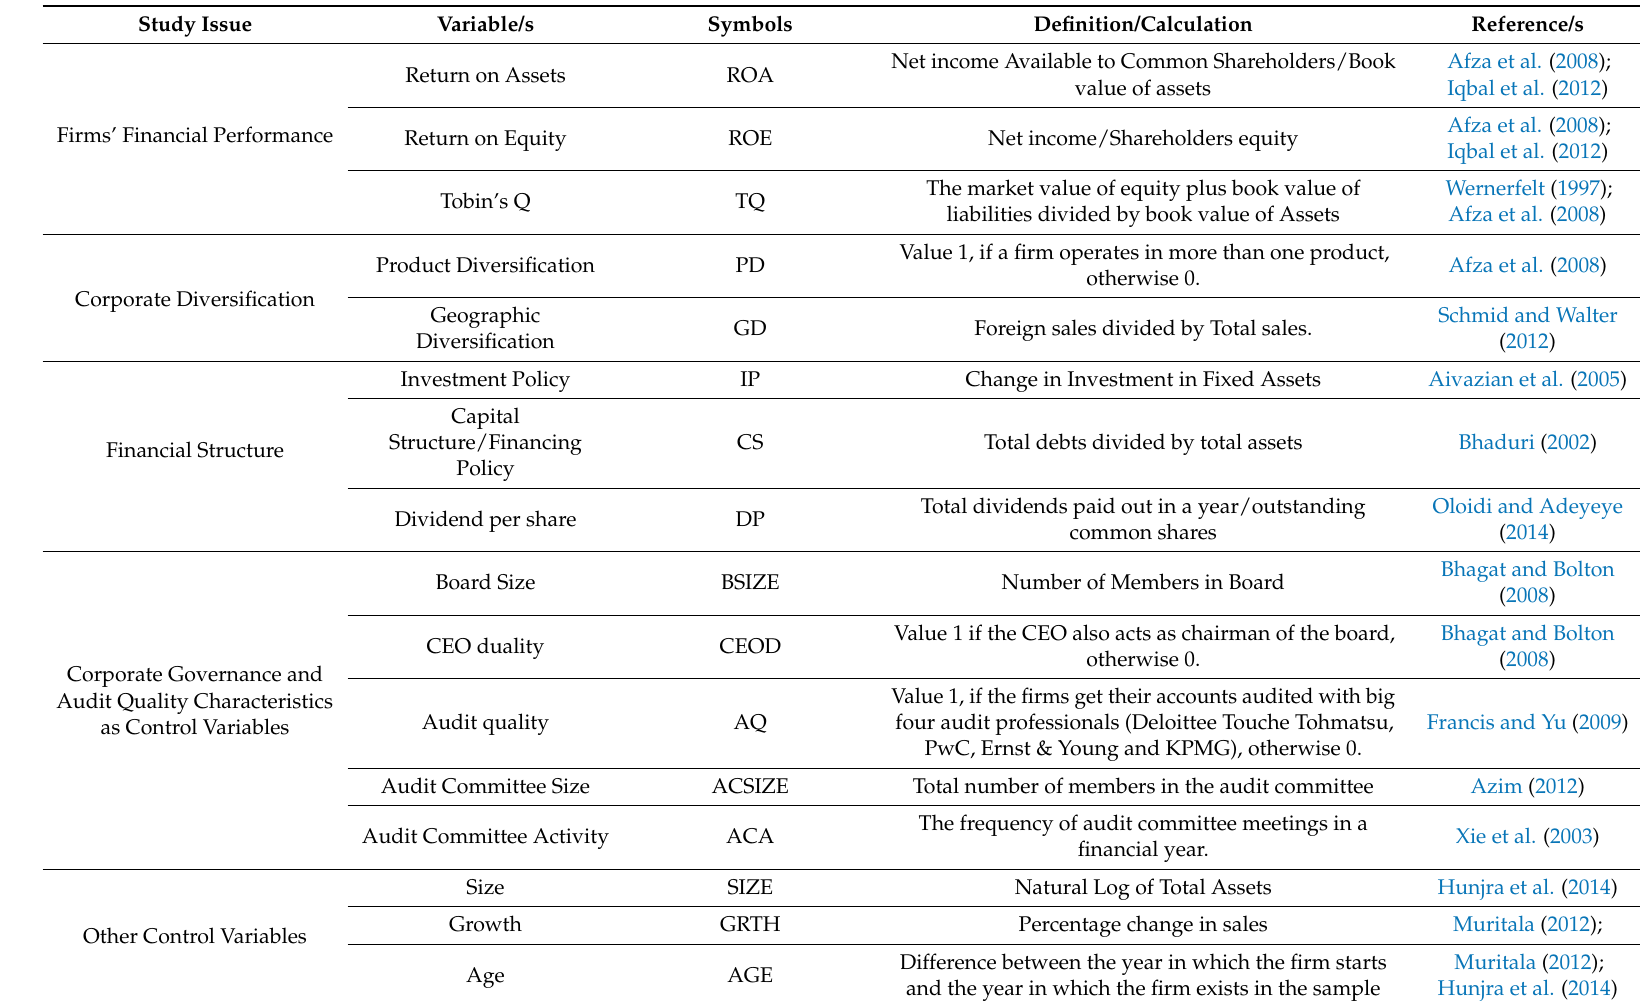
Table 2. Tabular summary of definitions of